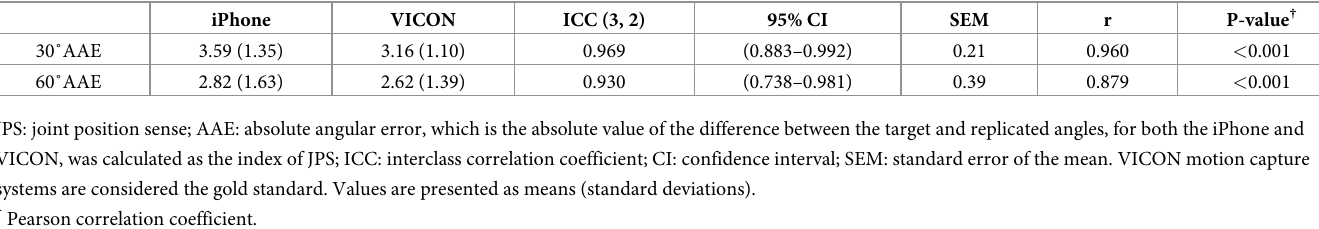
Table 1. Concurrent validation of iPhone JPS measurements with VICON JPS measurements.